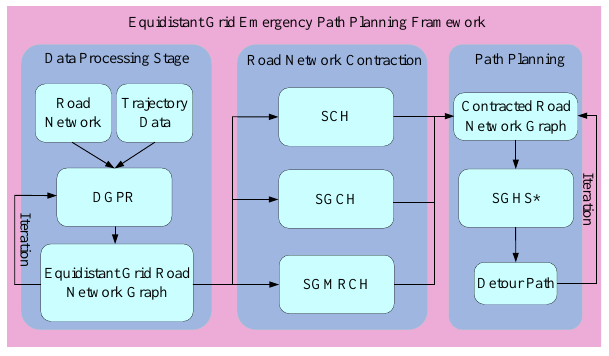
Figure 12. Schematic diagram of EGEPP